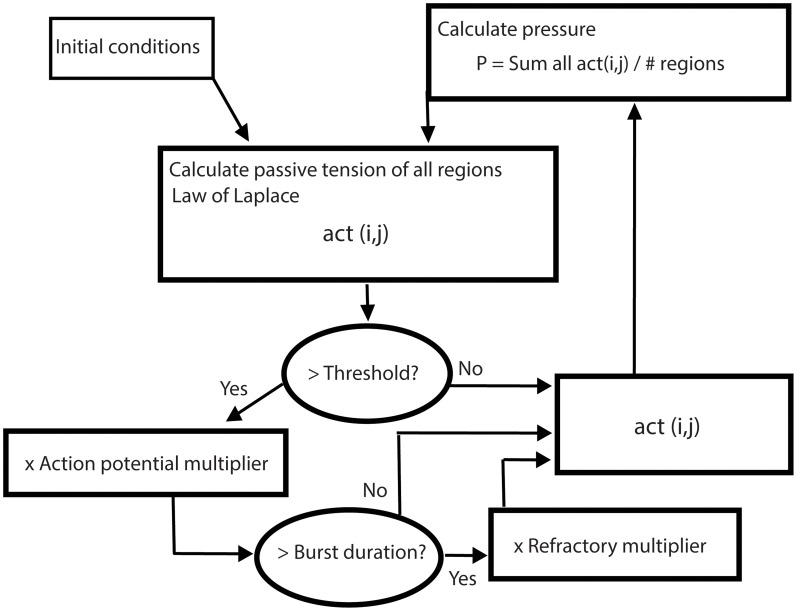
Flowchart of cellular automaton simulation.